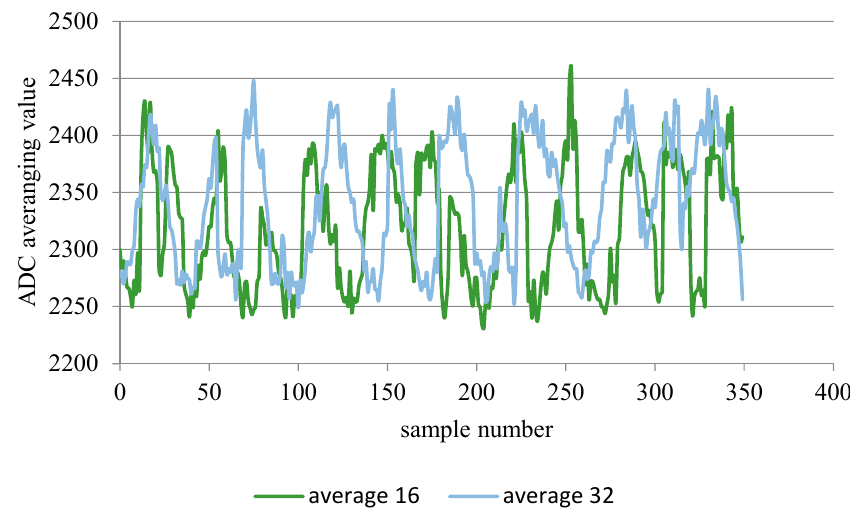
Figure 13. Averaging signals of 16 and 32 samples measured by the internal ADC of the TMS320F2812 samples at 700 rpm.